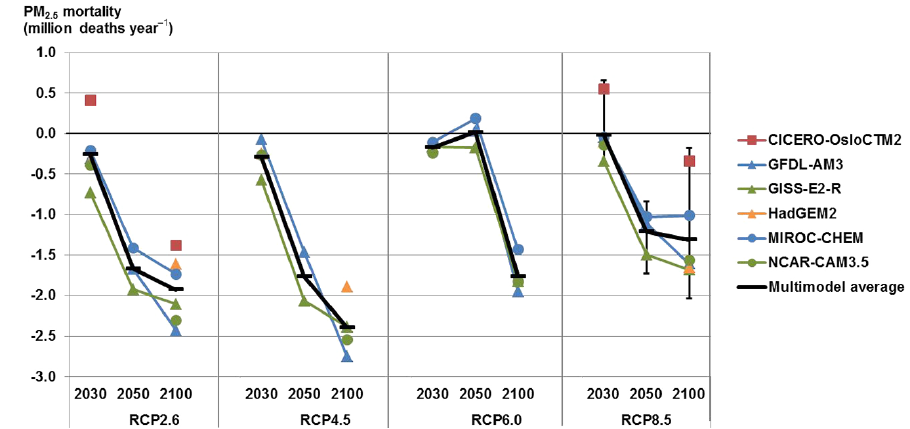
Figure 4. Estimates of future premature mortality (IHD + STROKE + COPD + LC) for PM 2 . 5 calculated as a sum of species, for all RCP scenarios in 2030, 2050 and 2100, showing global mortality for six models and the multi-model average (milliondeathsyear − 1 ), for future air pollutant concentrations relative to 2000 concentrations. Uncertainty shown for the RCP8.5 multi-model average is the 95% CI, including uncertainty in RR and across models.